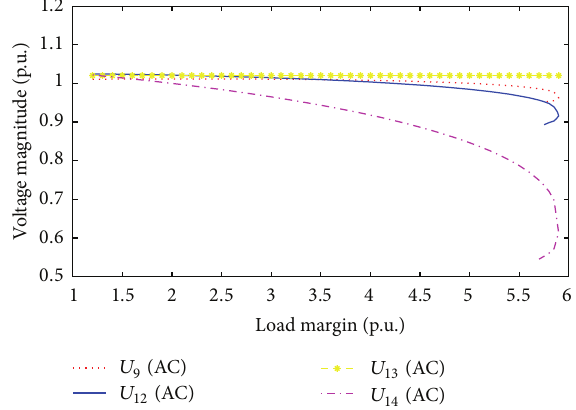
Figure 6: PV curves for modified IEEE-14 bus system in operating mode “3.”